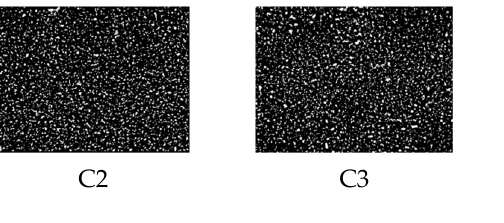
Figure 7. Dispersion image.